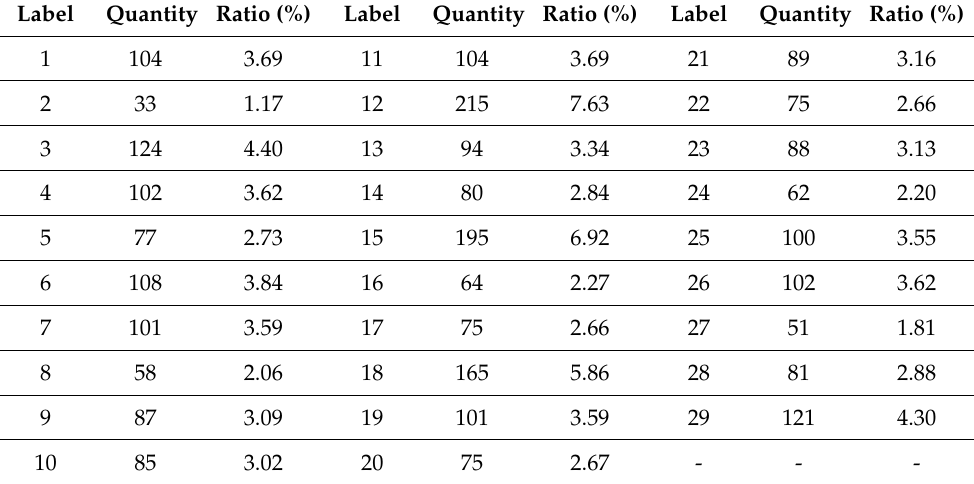
Table 1. Result of ship’s trajectory clustering.